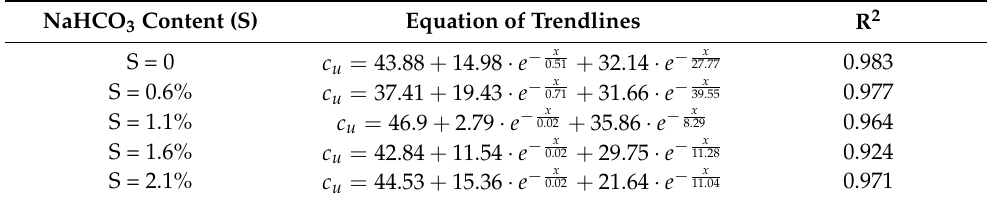
Table 7. Equation of trendlines of cohesion versus FTCs at different salt contents.